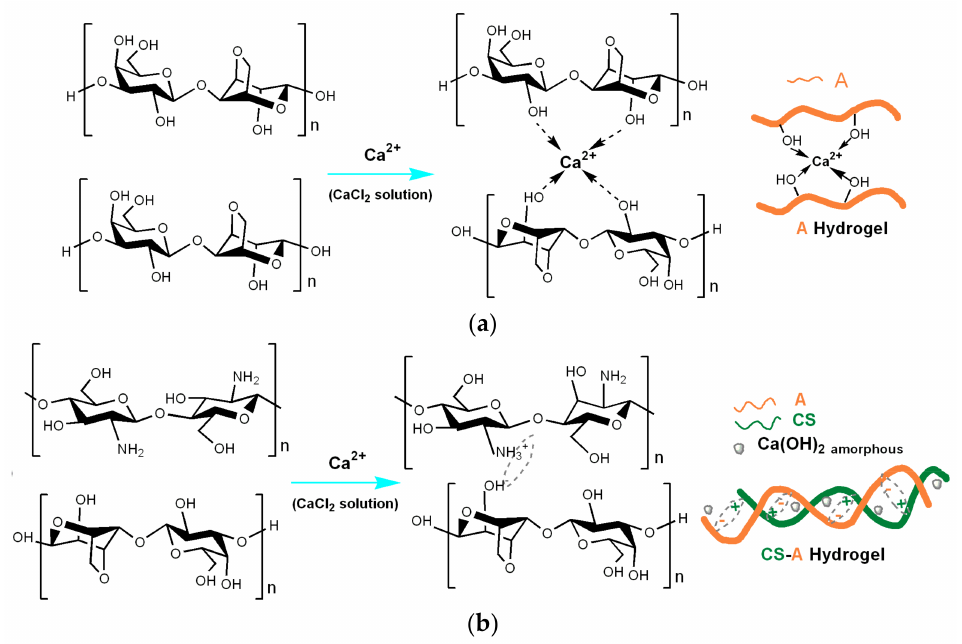
Figure 11. Formation of A-based hydrogel ( a ) and hybrid CS-A hydrogel ( b ) structure in the presence of Ca 2+